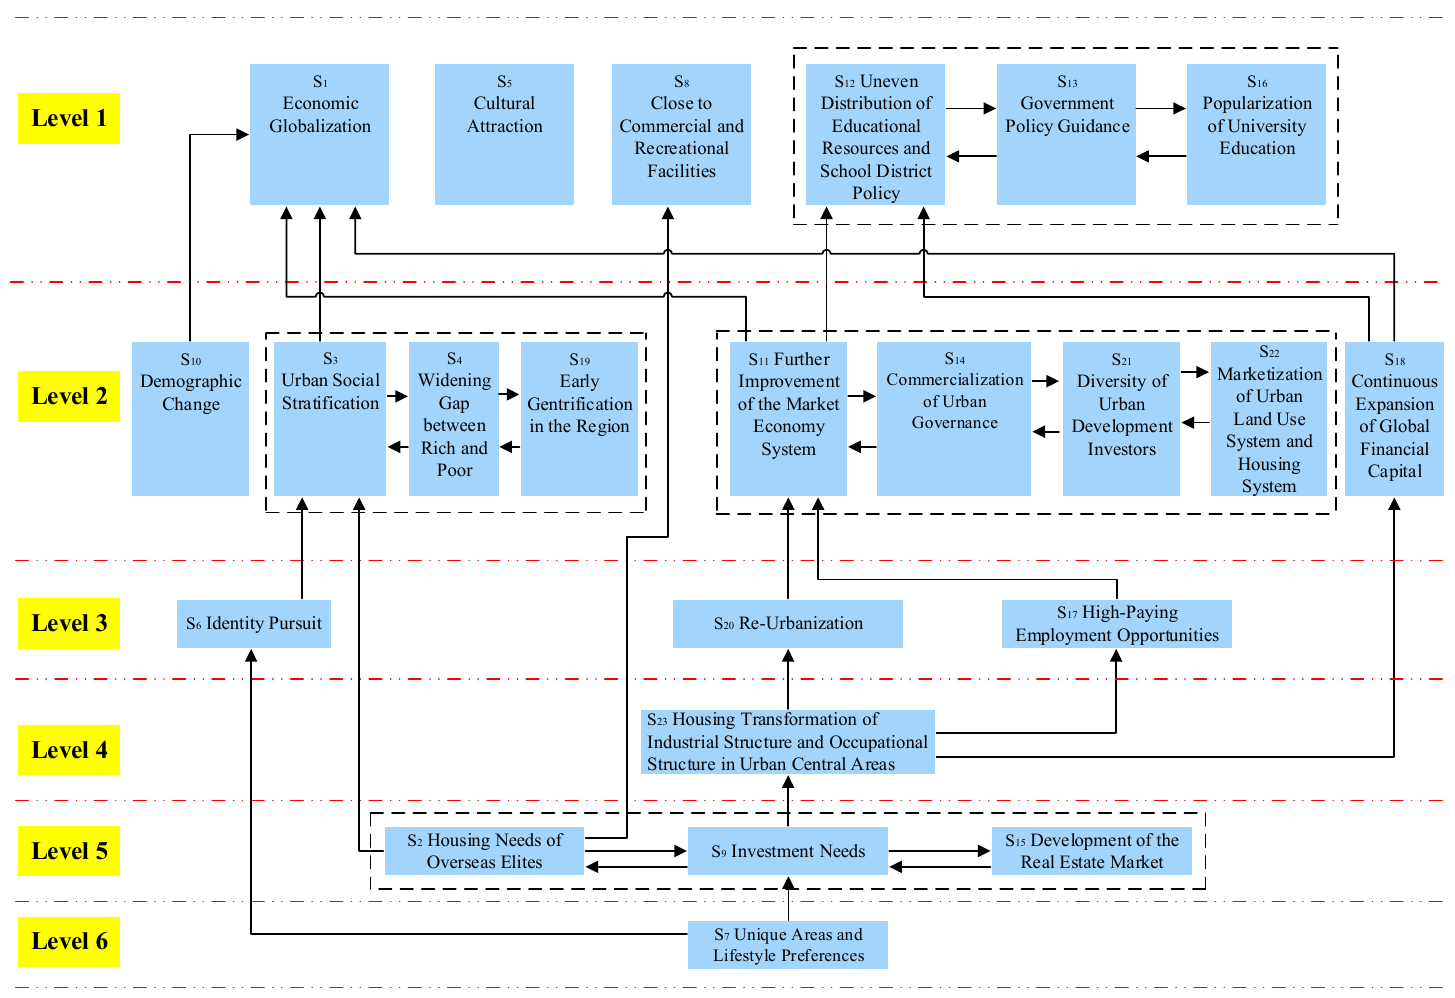
Figure 2. Interpretative Structure Modeling (ISM) digraph for the dynamic factors.